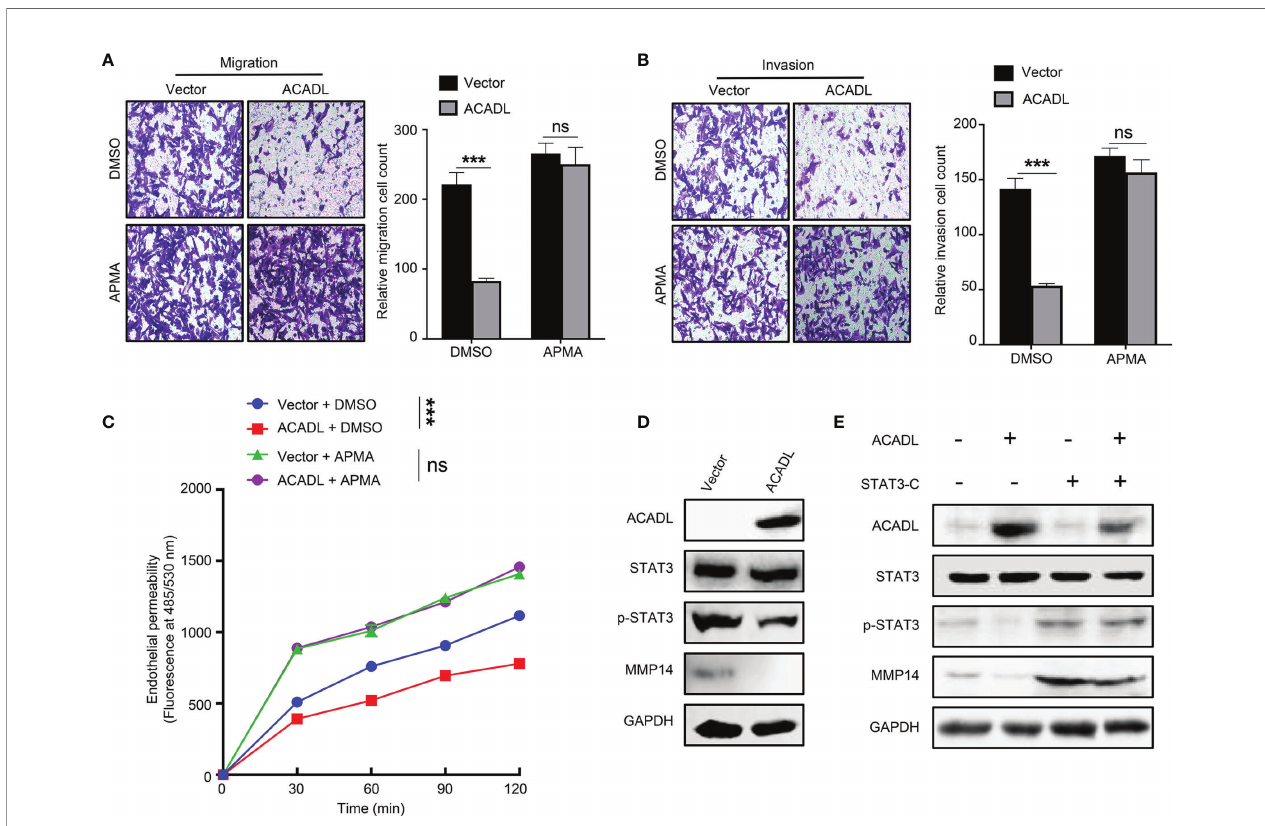
FIGURE 6 | ACADL inhibits HCC metastasis by downregulating MMP14/STAT3 signaling pathway. (A, B) Transwell of MHCC97H cells overexpressing ACADL or those in control cells treated with APMA (30 m M) or DMSO. Original magni fi cation, 200×. (C) Permeability of HUVEC monolayers was analyzed by measuring the fl uorescence of diffused FITC-dextran (70 kDa) across the Transwell membrane for the indicated time (mean ± SEM, n = 6, paired t test). (D) Cell lysates from indicated cells treated with overexpressing ACADL were subjected to immunoblot for ACADL, MMP14, STAT3, p-STAT3, and GAPDH. (E) MHCC97H cells were cotransfected with ACADL and STAT3-C plasmids for 24 h. Cells lysates were subjected to an immunoblot analysis for ACADL, MMP14, STAT3, p-STAT3, and GAPDH. Data represent three independent experiments. ns, no signi fi cance; ***P < 0.001 compared with